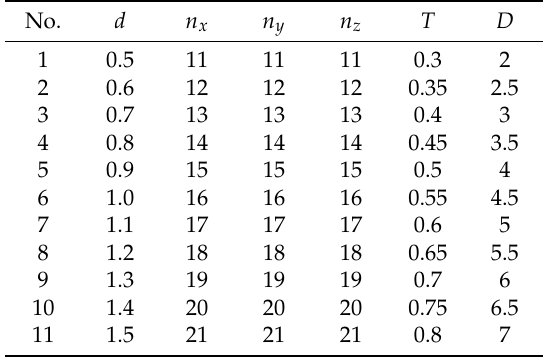
Table 7. Parameter-level table for the improved storage structure with a square column structure.